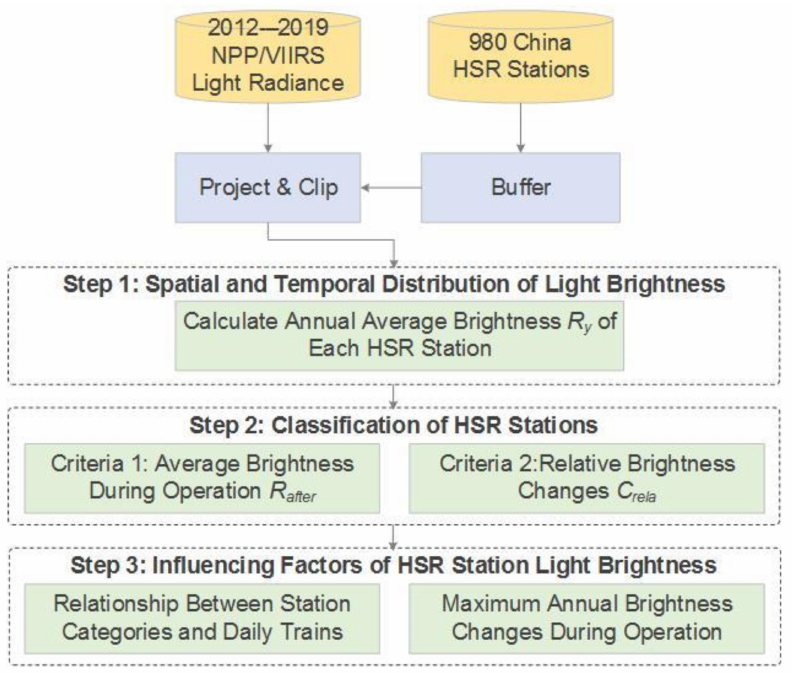
Figure 2. Method flow